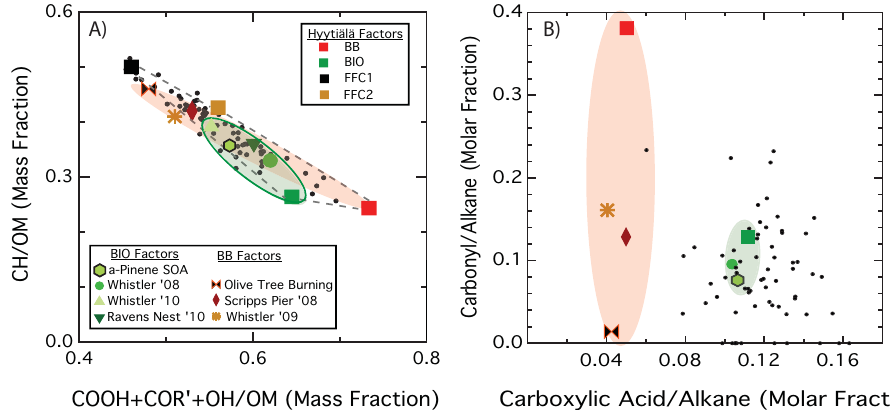
Fig. 7. (A) Distribution of oxygenated functional groups in ambient aerosol (black circles) and PMF factors in terms of mass fractions for biogenic and biomass burning factors: Hyytiälä, Whistler 2008 (Schwartz et al., 2010), Whistler 2009 (Takahama et al., 2011), Whistler 2010 (including Raven’s Nest) (Ahlm et al., 2012), Scripps Pier 2008 (Hawkins and Russell, 2010), POA formed from aged olive tree burning emissions (Kostenidou et al., 2013) and SOA from α -pinene oxidation (Chhabra et al., 2011). (B) Molar fractions of carbonyl (nonacid carbonyl) and carboxylic acid. Markers correspond to those presented in legend found in (A) . Red and green shaded regions correspond to typical distributions of biomass burning and biogenic factors,